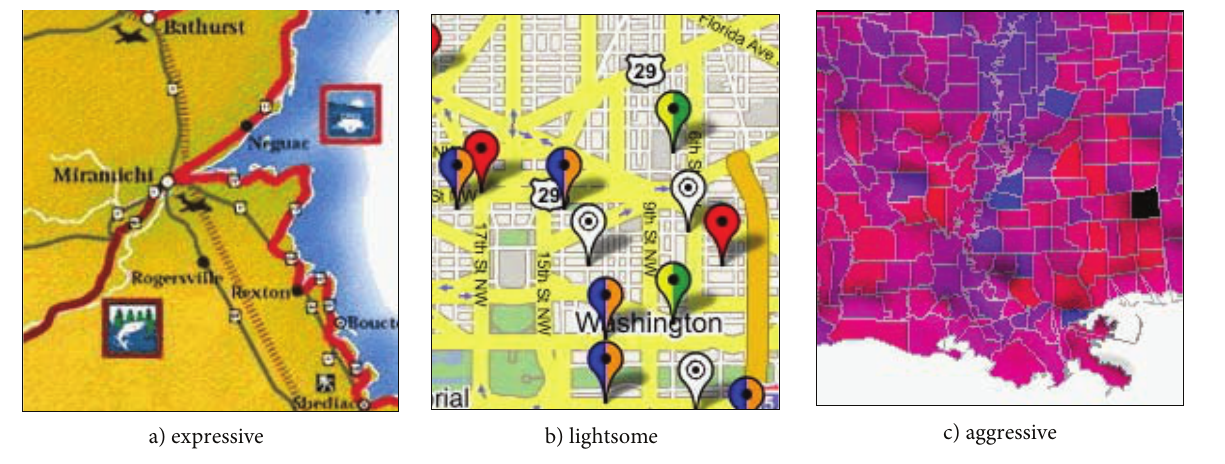
Fig. 7. Samples of expressive